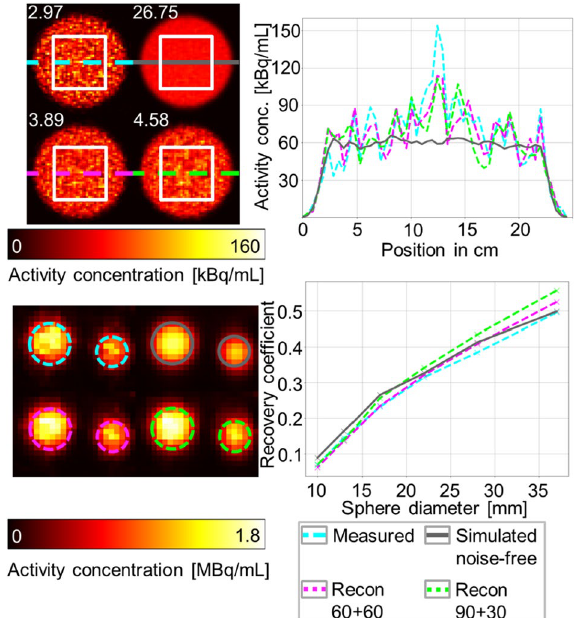
Fig. 8 Analysis of physical phantom measurements. Left: Transversal slices of SPECT/CT reconstructions of the filled Jaszczak (top) and the NEMA phantom (bottom) using 120 projections. For the sake of clarity, only a section containing the two largest spheres are shown for the NEMA phantom. The missing projections for Recon 60 60 (magenta) and Recon 30 90 (green) were generated using u‑nets U1 and U4–U6, + + respectively. The white numbers in the upper left panel are the signal‑to‑noise ratios calculated in the white boxes. For the Jaszczak phantom, the cross section of the activity distribution along the colored lines is shown on the right. For the NEMA phantom, the recovery of the spheres is shown on the